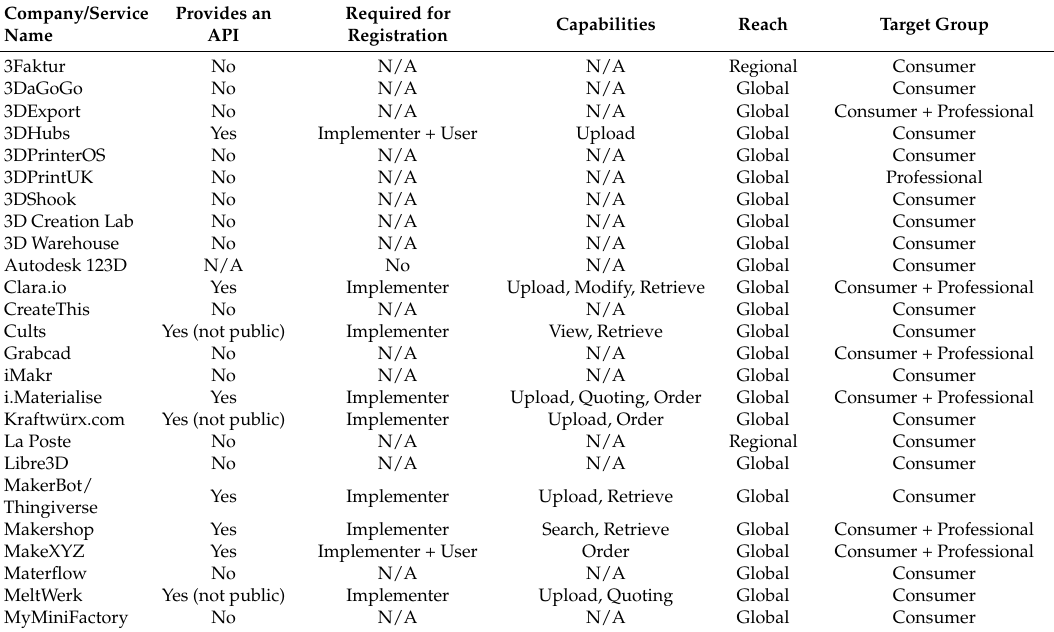
Table 3. 3D printing platforms and services and their APIs—Part 1.